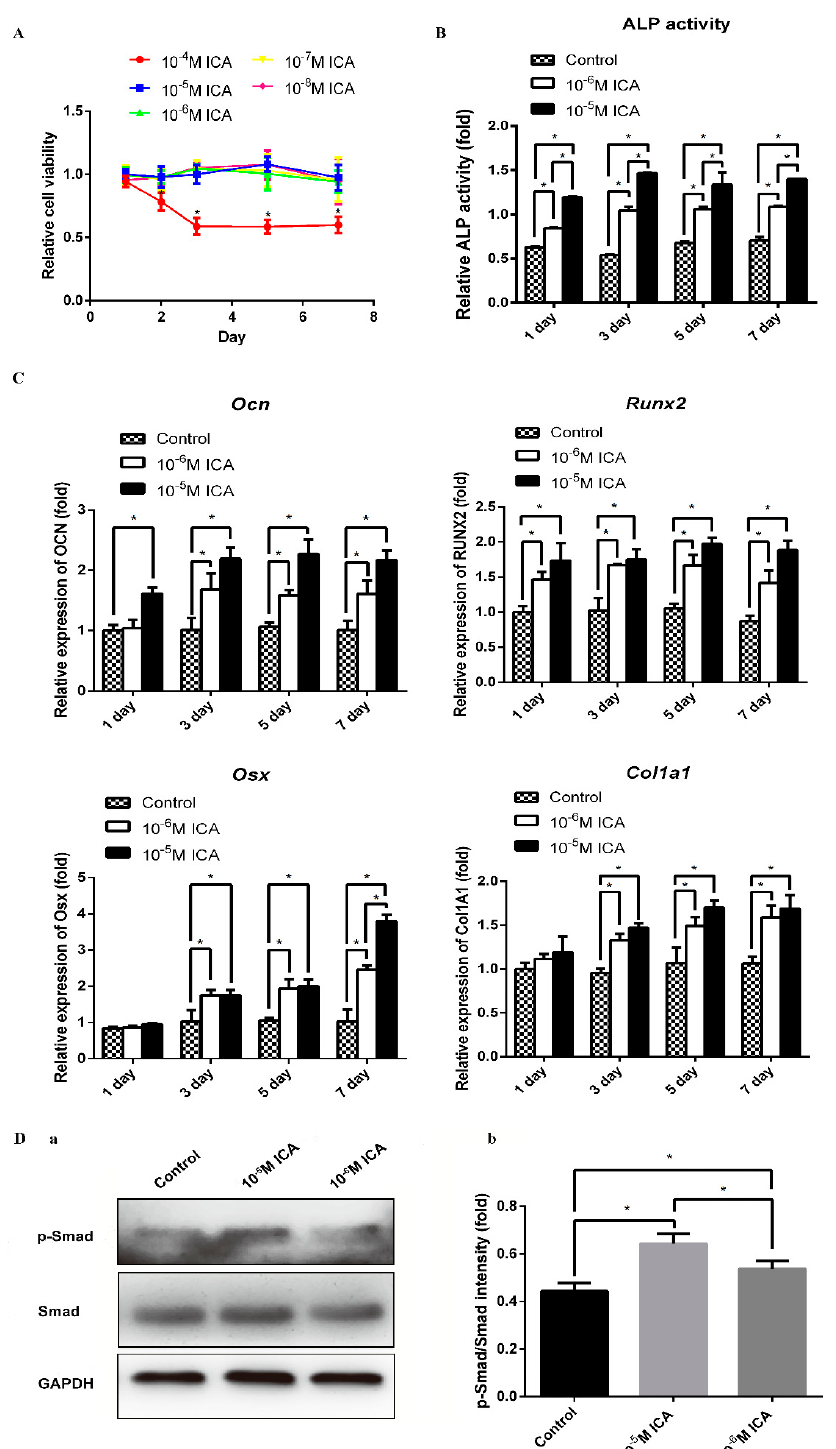
Figure 3. ICA enhances the BMP2-mediated osteogenic di ff erentiation of C2C12 cells. ( A ) Cytotoxic e ff ect of ICA on C2C12 cells. C2C12 cells were cultured in basal medium with various concentrations of ICA (10 − 8 , 10 − 7 , 10 − 6 , 10 − 5 and 10 − 4 M) for 1, 2, 3, 5, and 7 days, then CCK8 assay was performed to test the cytotoxic e ff ect of ICA. The ALP activity ( B ) and the mRNA expression levels ( C ) after 1, 3, 5 and 7 days of osteogenic induction with di ff erent concentrations of ICA (0, 10 − 6 and 10 − 5 M). ( D-a ) The protein expression levels of phosphorylated Smad1 / 5 / 9 and total Smad1 with di ff erent concentrations of ICA (0, 10 − 6 and 10 − 5 M). ( D-b ) Relative density of the protein expression levels. All data are presented as the mean ± SD ( n = 3). * p <